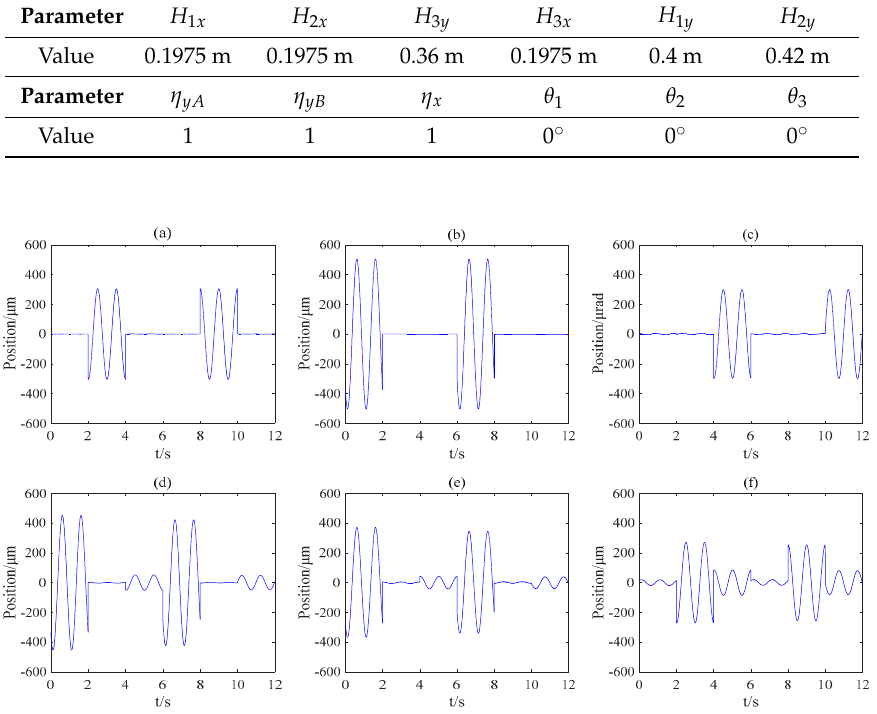
Figure 9. The displacements of the stage measured by the interferometers in X, Y, Rz directions ( a – c )